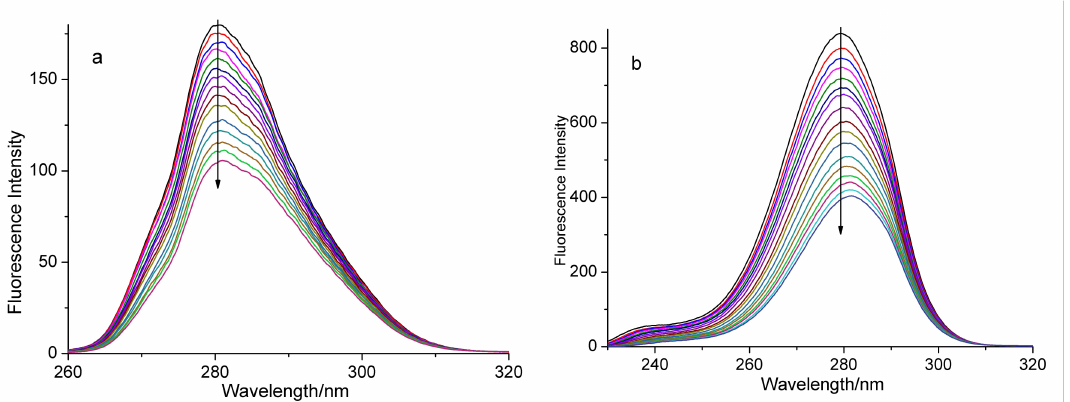
Figure 6. Synchronous fluorescence spectra of BSA in the presence of increasing amounts of complex 2 at ∆ λ = 15 nm ( a ) and at ∆ λ = 60 nm ( b ). The arrows show the emission intensity changes upon the increasing concentrations of complex 2